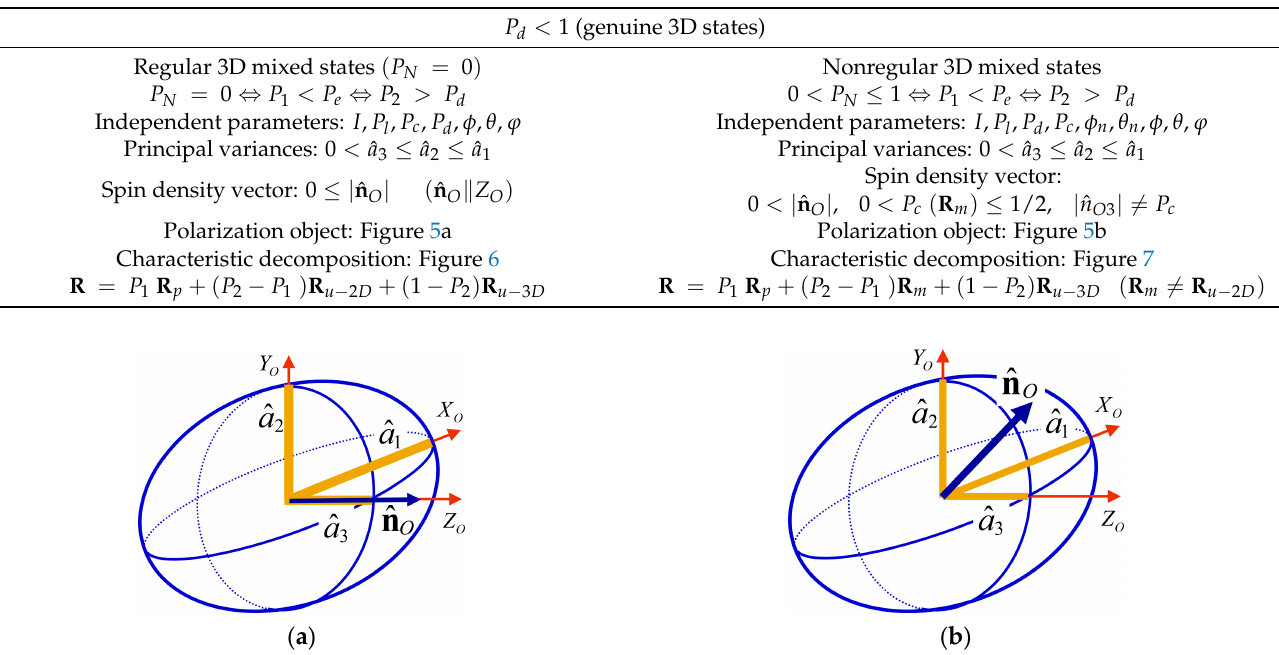
Table 2. Classification of genuine 3D states P d < 1.